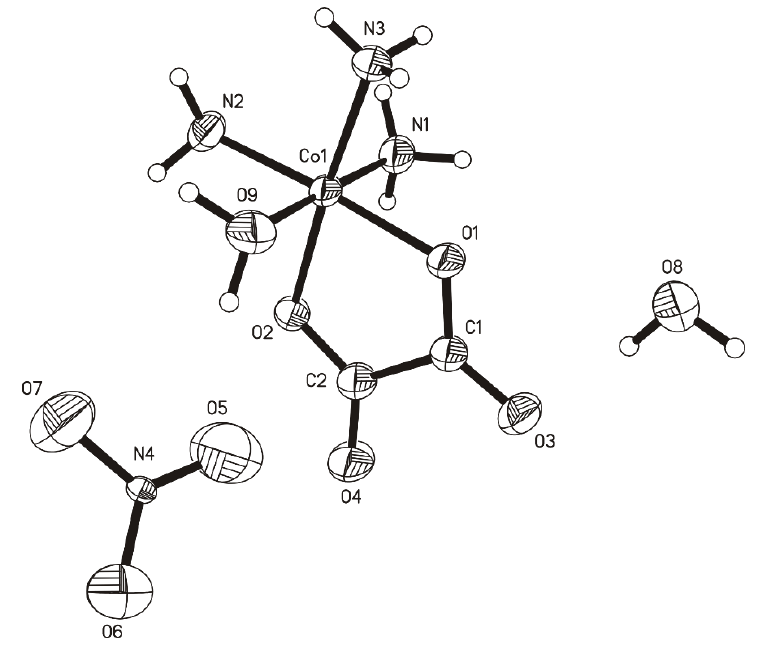
Figure 1. Structure of fac -[Co(NH 3 ) 3 (C 2 O 4 )(H 2 O)]NO 3 ·H 2 O ( 2 ) in the crystal, showing the atom-labeling scheme. Displacement ellipsoids are drawn at the 50% probability level.